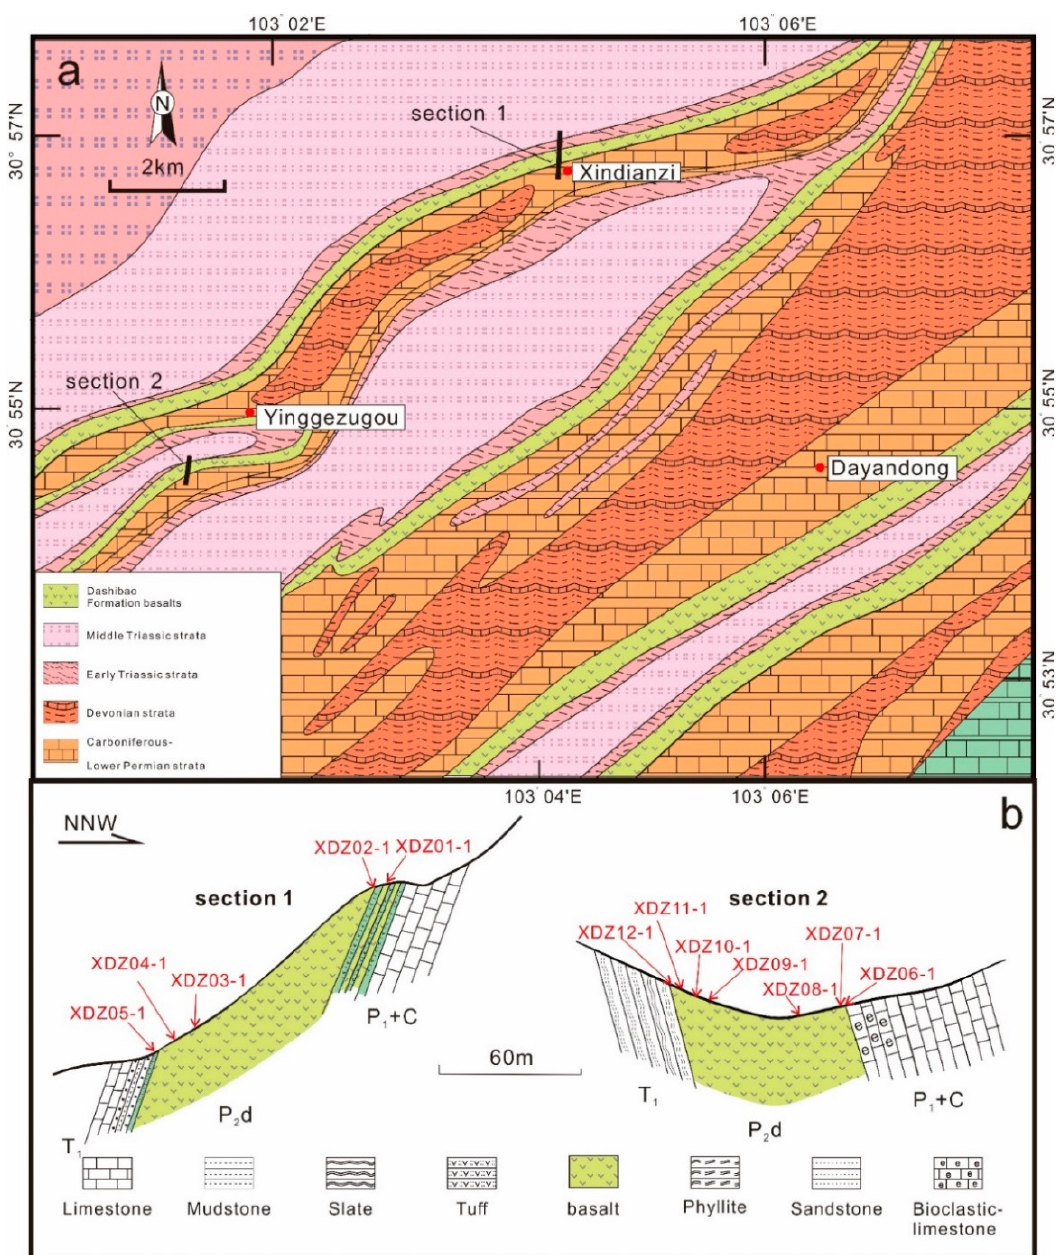
Figure 2. ( a ) Schematic geological map of the Xindianzi area (modified after [13,14]). ( b ) Geological sections 1 and 2 with Dashibao basalt and sample location.